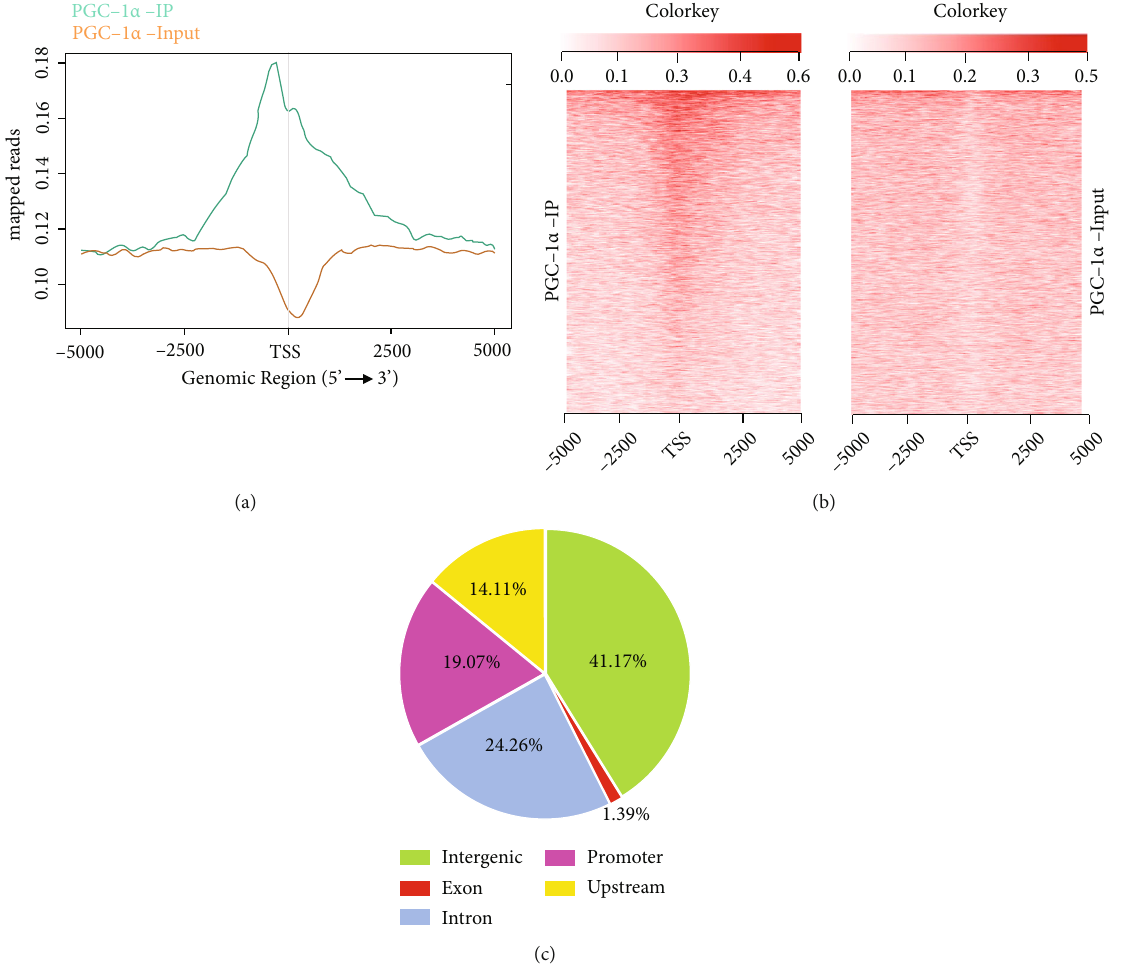
Figure 2: Identi fi cation of genome-wide transcriptional targets of PGC-1 α in HT-22 cells. (a) The density distribution for ChIP-Seq peaks of PGC-1 α . (b) Heat maps in PGC-1 α -IP vs. PGC-1 α -input; (c) ChIP-Seq peaks of PGC-1 α distributed over important genomic